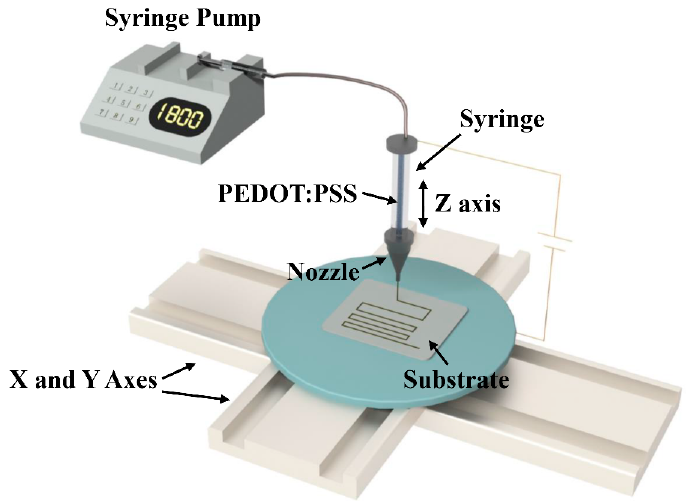
Figure 1. The schematic diagram of the near-field electrohydrodynamic direct-writing (NFEDW) method. PEDOT:PSS—poly(3,4-ethylenedioxythiophene):poly(styrenesulfonate).